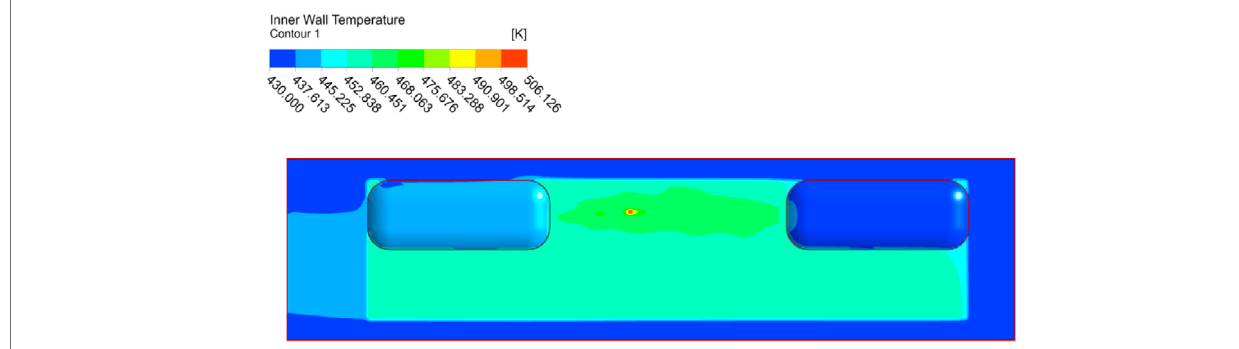
FIGURE 11 | Temperature distribution of cladding with pillow-like blisters.